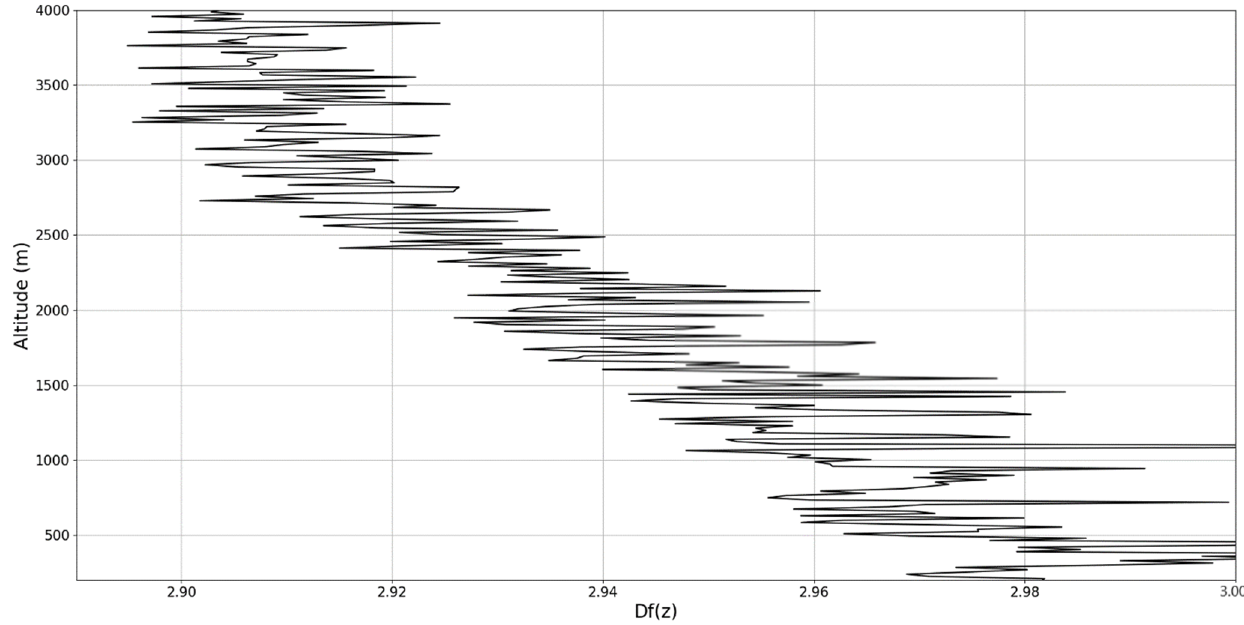
Figure 22. Zoomed-in D (cid:2890) profile, λ = 1064 nm , Gala ț i, Romania, 22 December 2021.